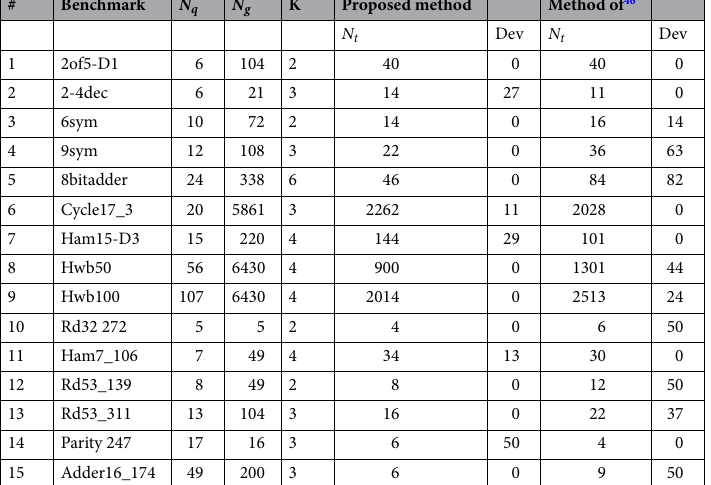
Table 3. The number of teleportations ( N t ) and Dev of the proposed algorithm in comparison with the method of 46 .